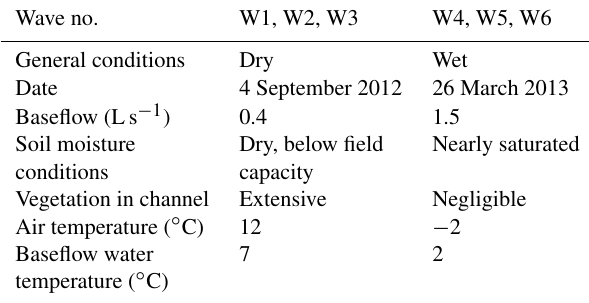
Table 1. Initial conditions before the